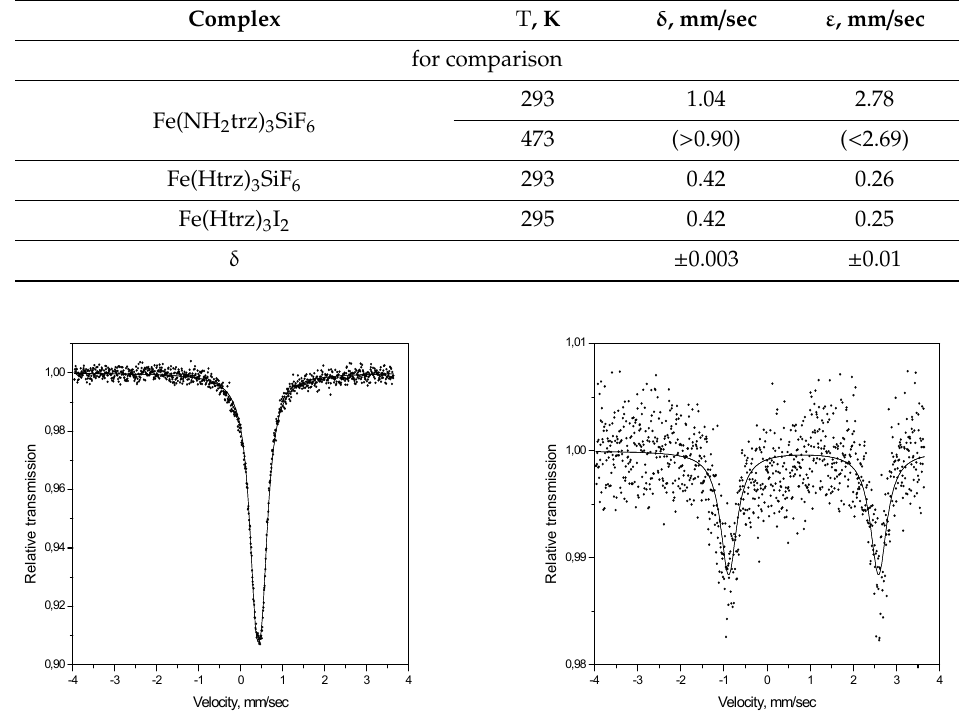
Figure 9. Mössbauer spectra of [Fe(HC(pz) 3 ) 2 ]SiF 6 at 295 K (left ) and at 473 K ( right ).